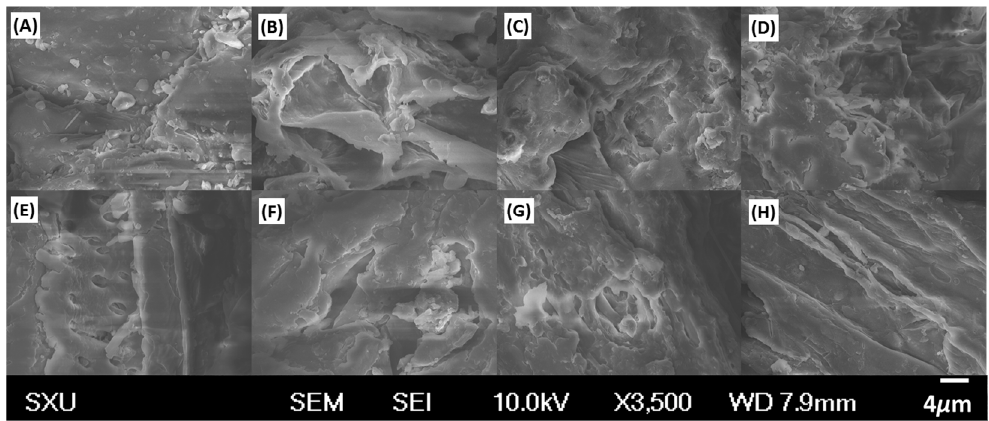
Figure 8. SEM graphics of Radix Salviae miltiorrhizae samples. ( A ) Raw materials, ( B ) extracted by DES-based microwave-assisted, ( C ) 75% methanol-based microwave-assisted extraction, ( D ) water-based microwave-assisted extraction, ( E ) DES-based ultrasound-assisted treatment. ( F ) 75% methanol-based ultrasound-assisted extraction, ( G ) DES-based hot reflux-assisted extraction, and ( H ) 75% methanol-based hot reflux-assisted extraction.